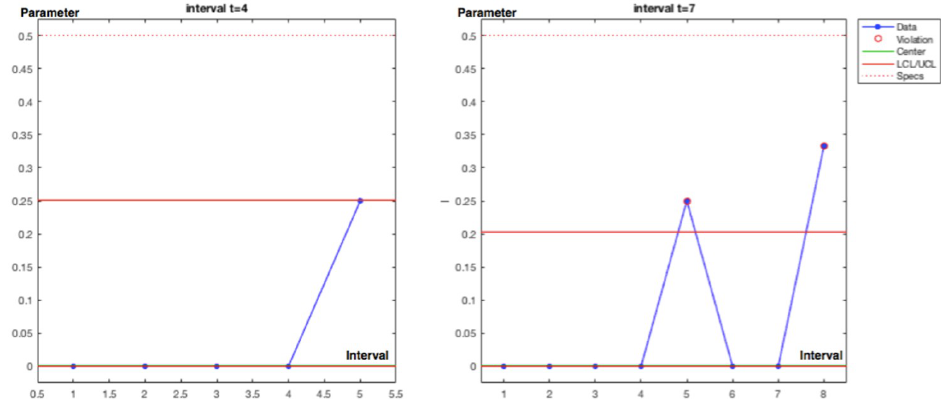
Figure 15. Poisson–gamma model. Recurrent with mean prior method. Charts based on posterior lambda evolution for intervals 4 and 7.